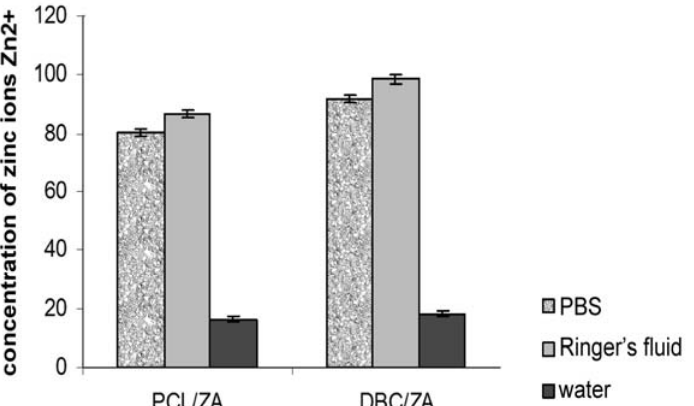
Figure 12. Changes in concentration of zinc ions in the immersion media PBS, Ringer’s fluid and water after 7 days’ incubation in conditions of short-term degradation (80 °C/5% CO